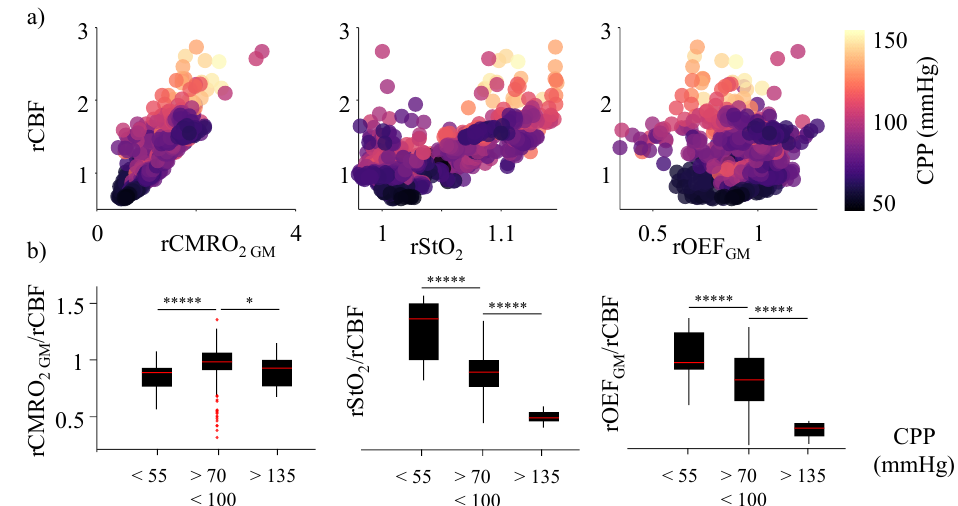
Figure 4. Use of tissue oxygenation metrics as an indicator of autoregulatory health. ( a ) Trends in estimated rCMRO 2 GM , rStO2, and rOEF GM as a function of recorded rCBF. A 2-min average of the data from all 4 subjects is shown as a point on the plot, color-coded by the average CPP (in the 2 min) at which it was recorded. The color scales from black (low CPP of ~40 mmHg) to light yellow (high CPP of ~160 mmHg). ( b ) The ratio of rCMRO 2 GM , rStO2, and rOEF GM to rCBF was calculated and split into 3 groups indicating impaired autoregulation: below the lower limit of autoregulation (<55 mmHg) and above the upper limit of autoregulation (>135 mmHg), and intact autoregulation (70 < CPP < 100 mmHg). Red horizontal lines indicate the median and the black solid box represents the 25th and 75th percentile of each group for the metrics. The red dots indicate the outliers for each group and the vertical line shows the spread of the respective distributions. The difference between two groups is shown by the horizontal line, with * to denote the significance. The p -value for all the indicated groups with five * was < 1 × 10 −4 and for the group with a single * was 0.02.